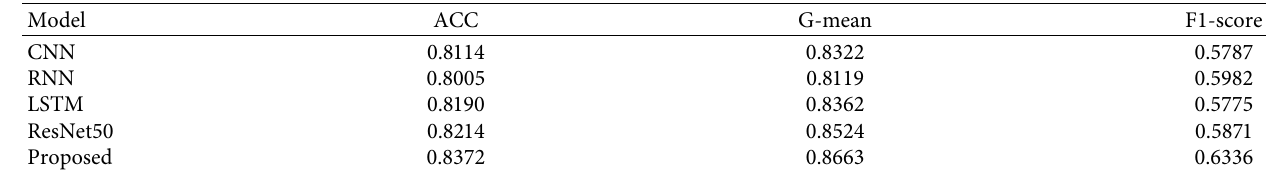
Table 9: Experimental results of each model.